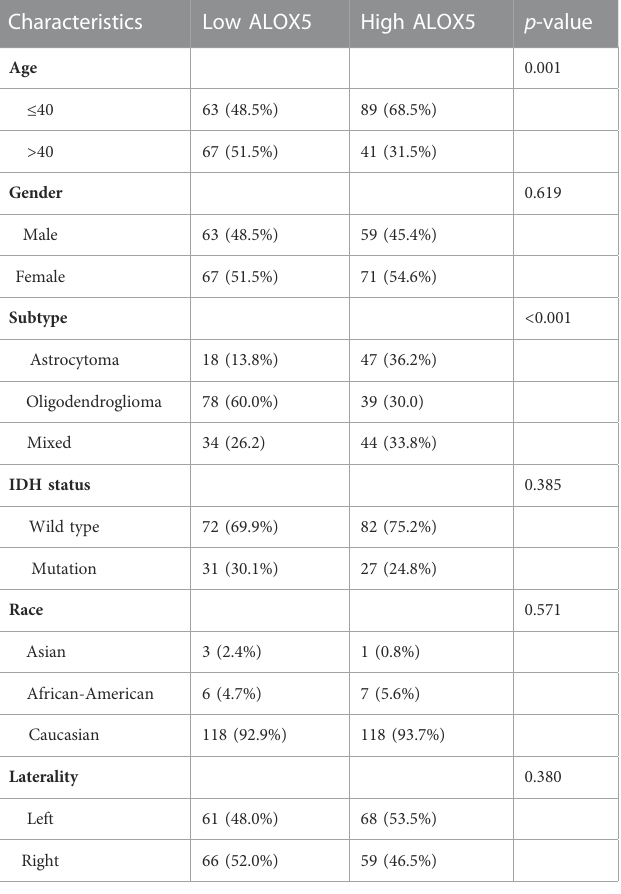
TABLE1AssociationofALOX5expressionwithclinicopathologicalcharacteristics in TCGA-LGG dataset. Characteristics